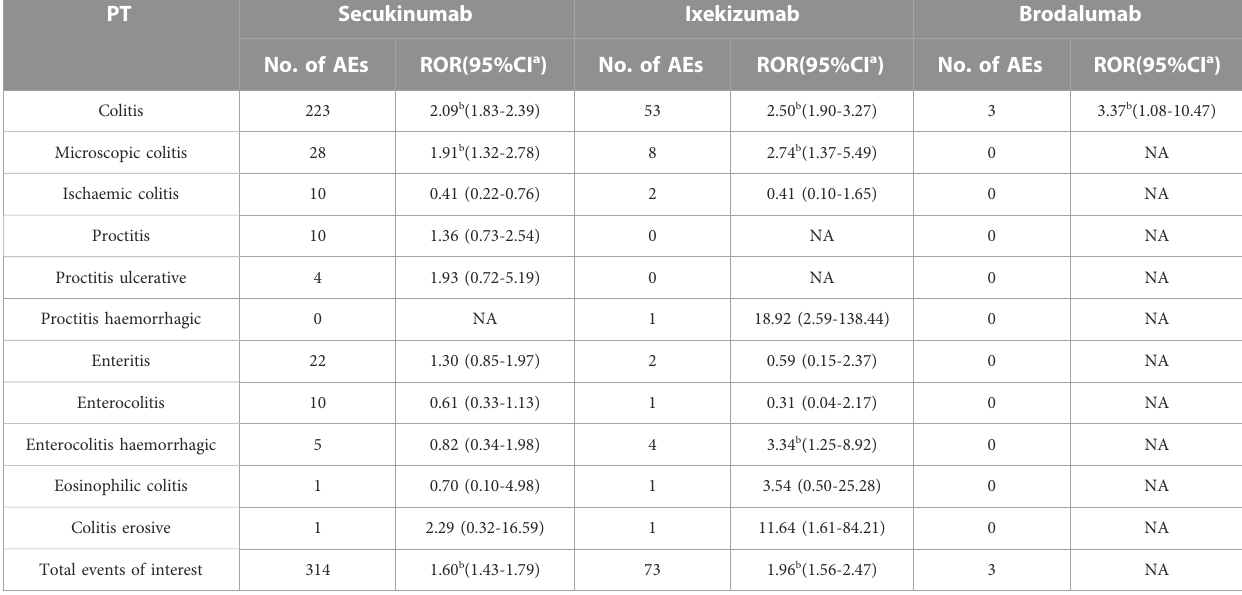
TABLE 3 Interleukin-17 inhibitors associated with Colitis and the reporting odds ratios in FAERS database.